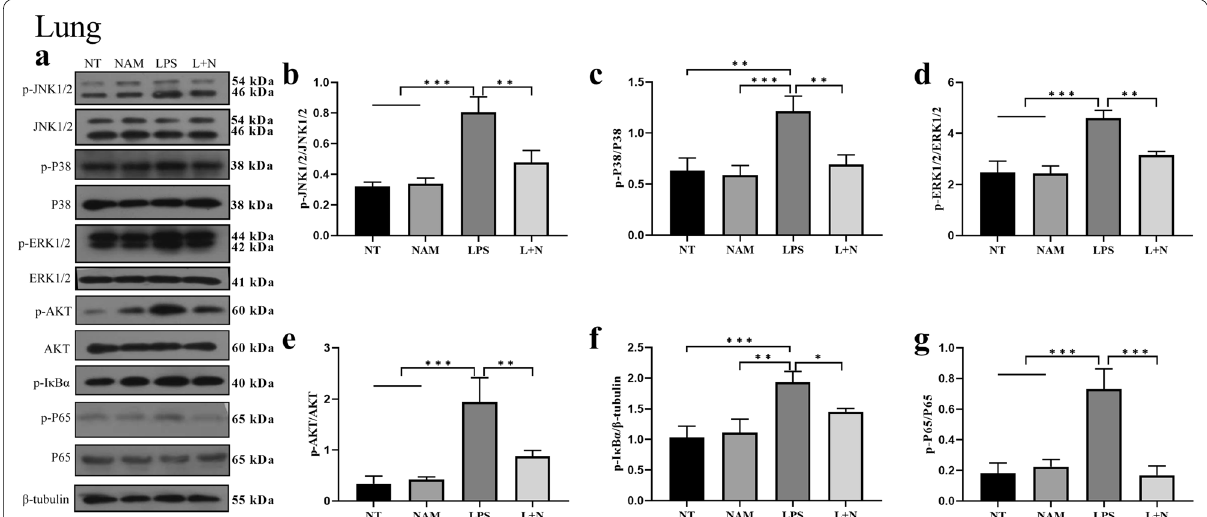
Fig. 4 The effect of NAM on MAPK and NF-κB signaling pathway in lung. a – g Lung tissues from different experimental groups were obtained 12 h after LPS administration and total protein extracted. The phosphorylation levels of ERK, JNK, P38, AKT, IκBα and P65 were determined via western blot and quantitated via densitometry using β-tubulin as an internal control. The values are presented as the mean *** p < 0.001 and **** p < 0.0001)